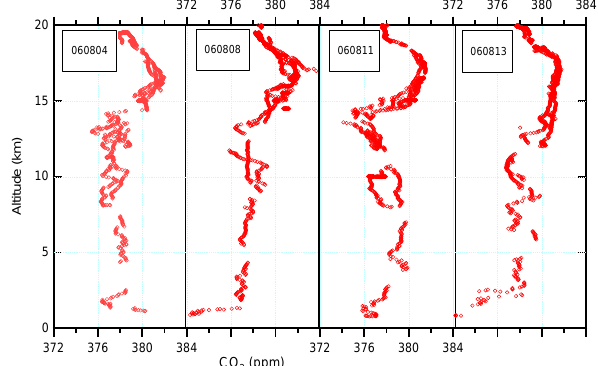
Fig. 2. Potential temperature profiles of CO 2 for the flights on 4, 8, 11 and 13 August,